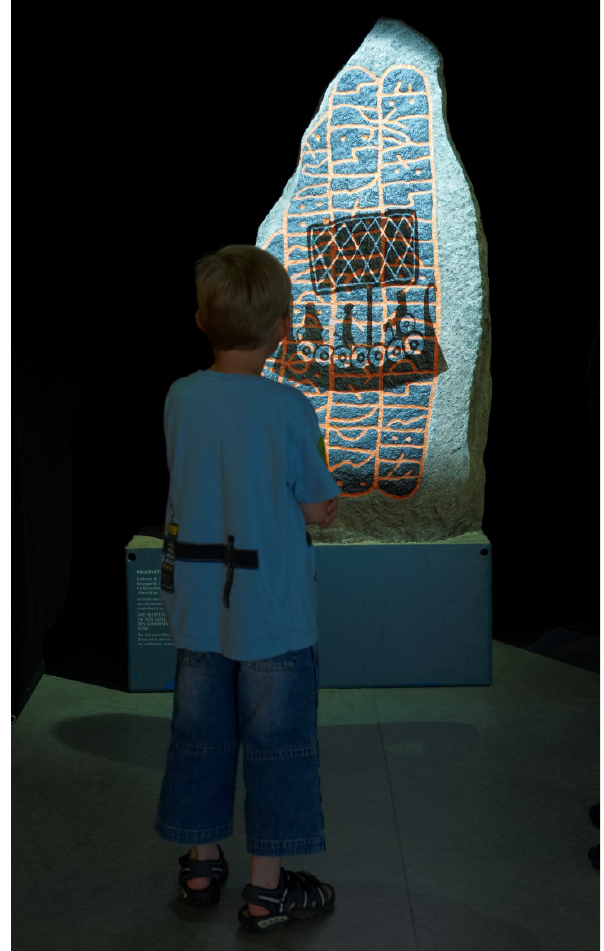
Figure 6. Interactive animation projected directly onto the authentic runic stone. Photo: Museum Østjylland (East Jutland Museum), Denmark. Used with